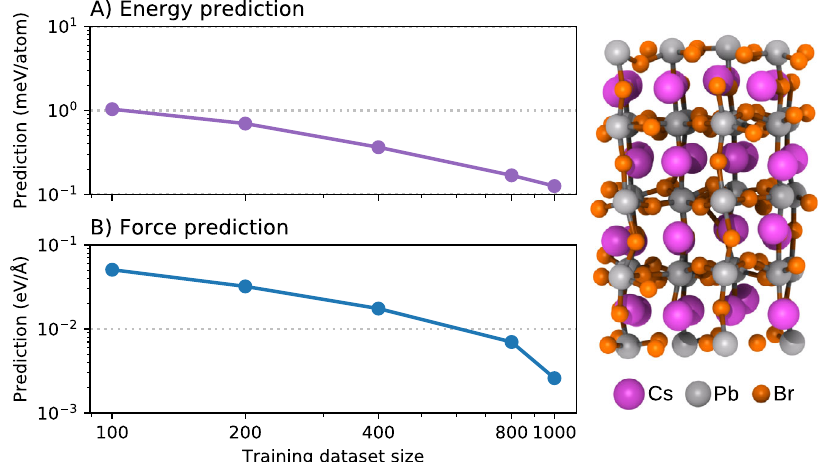
Fig. 4 Model performance on large supercells. A Energy and ( B ) force learning curves of the BIGDML model for CsPbBr 3 perovskite. The right panel displays the supercell structure containing 160